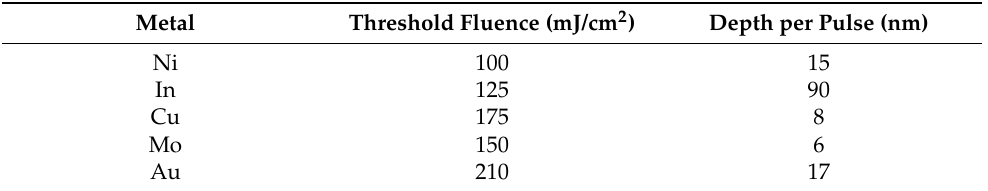
Table 4. Threshold laser fluence and depth per pulse for fluence 300 mJ/cm 2 derived from the laser (500 fs, 248-nm) ablation studies of several metals. Reprinted with permission